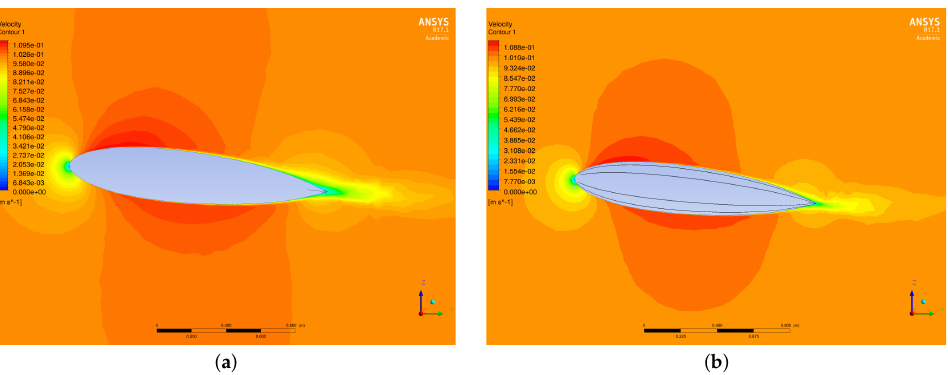
Figure 7. Velocity contour. ( a ) Parametric shape without ridges. ( b ) Parametric shape with ridges. Simulations performed using ANSYS Fluent ® R17.1 [55].